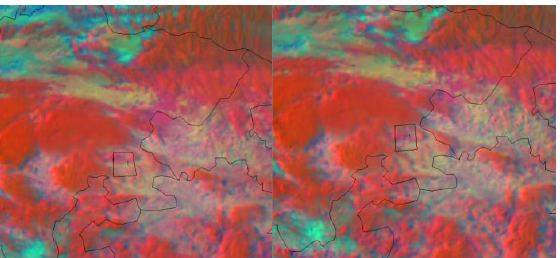
Figure 4. RGB image (left:17:38 LST, right:17:53 LST)